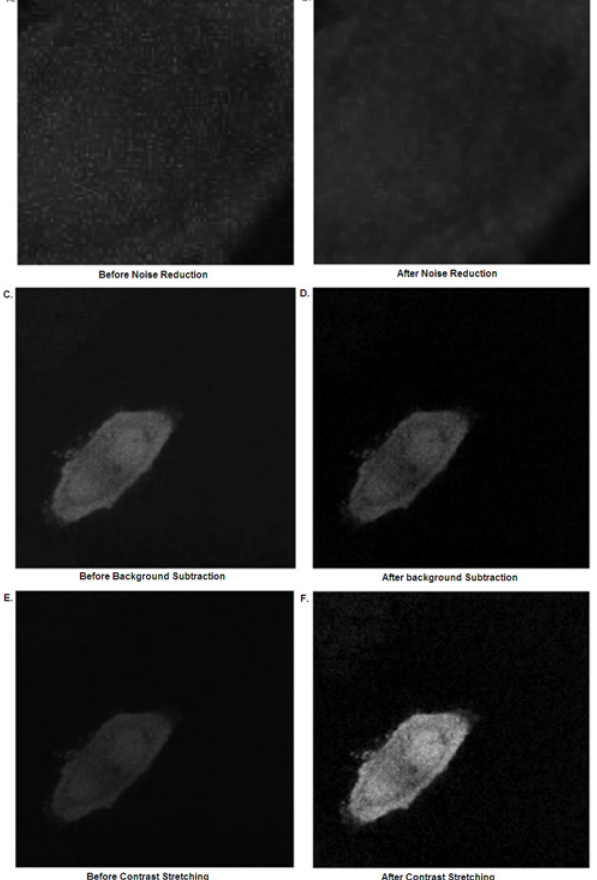
Fig 2. Image processing. A zoomed confocal image of a HeLa cell transiently expressing photo-converted Dendra2 (A) before and (B) after application of a median filter; (C) before and (D) after subtraction of the pre- conversion red image (background); (E) before and (F) after application of the Contrast Stretching